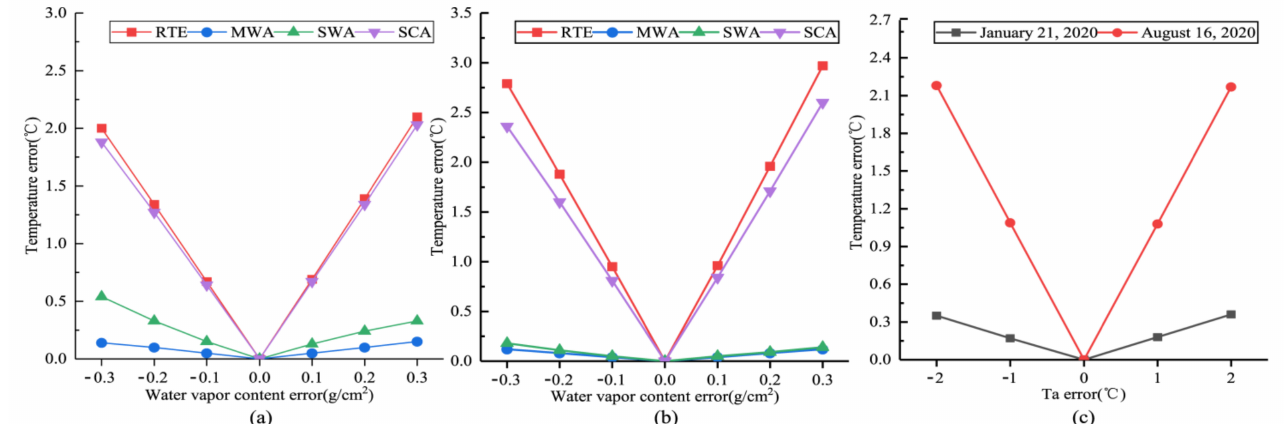
Figure 9. The errors in LST retrieval results due to changes in different parameters. ( a , b ) are the LST estimation errors resulting from the estimation errors in atmospheric water vapor content on 21 January 2020 and 16 August 2020, respectively. ( c ) is the LST estimation error of MWA due to the estimation error in effective atmosphere temperature.